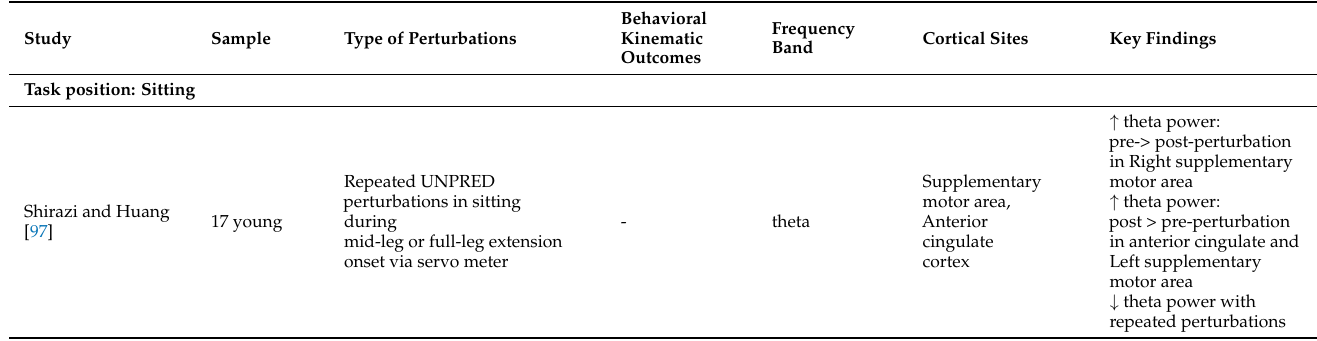
Table 6. Changes in frequency spectrums recorded via electroencephalography (EEG) in response to repeated unpredictable (UNPRED) mechanical perturbations (RQ2).